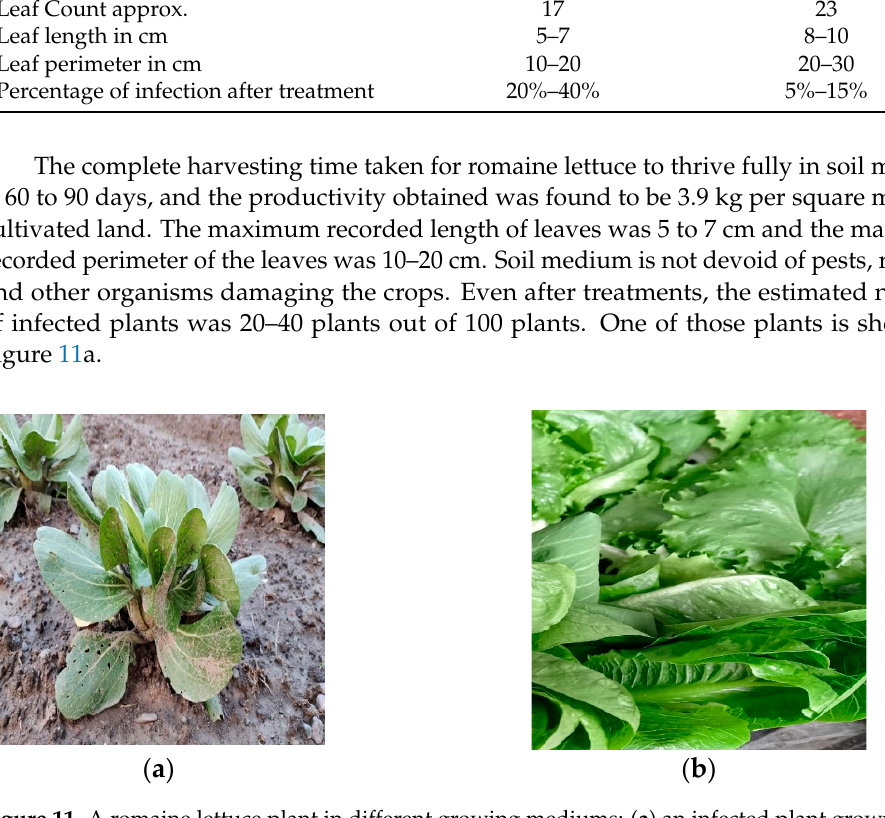
Figure 11. A romaine lettuce plant in different growing mediums: ( a ) an infected plant grown in soil; ( b ) a healthy plant grown in a hydroponic setup. ( b ) a healthy plant grown in a hydroponic